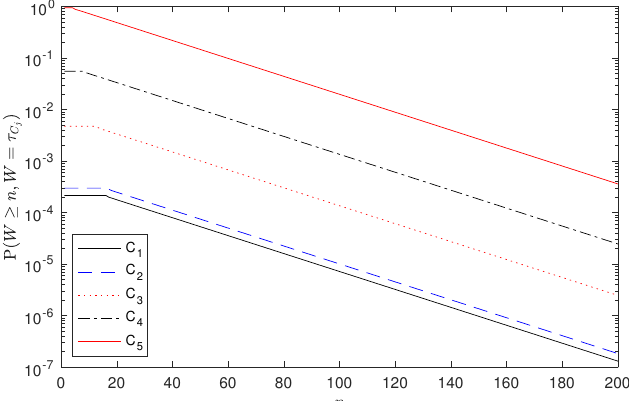
) , j = 1, . . . ,5 for Example 2. j